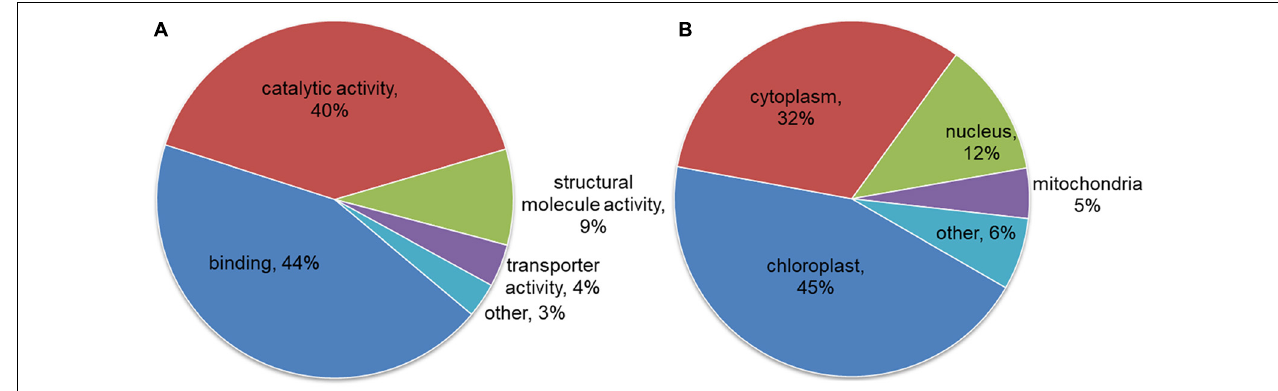
FIGURE 3 | Functional classification for all the modified malonylproteins in maize. (A) Classification for the for the modified proteins based on molecular function annotation. (B) Analysis the subcellular localizations of the modified proteins in